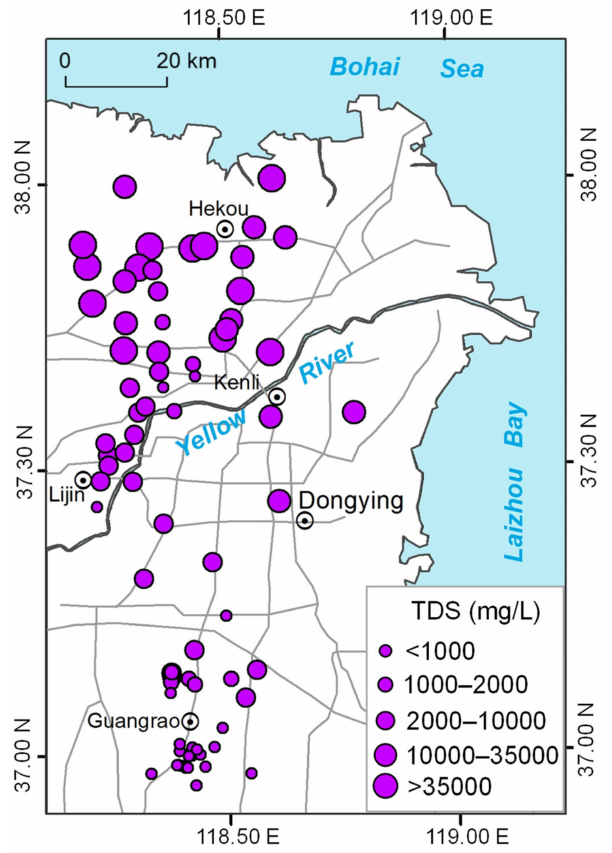
Figure 3. Spatial distribution of groundwater total dissolved solids (TDS).